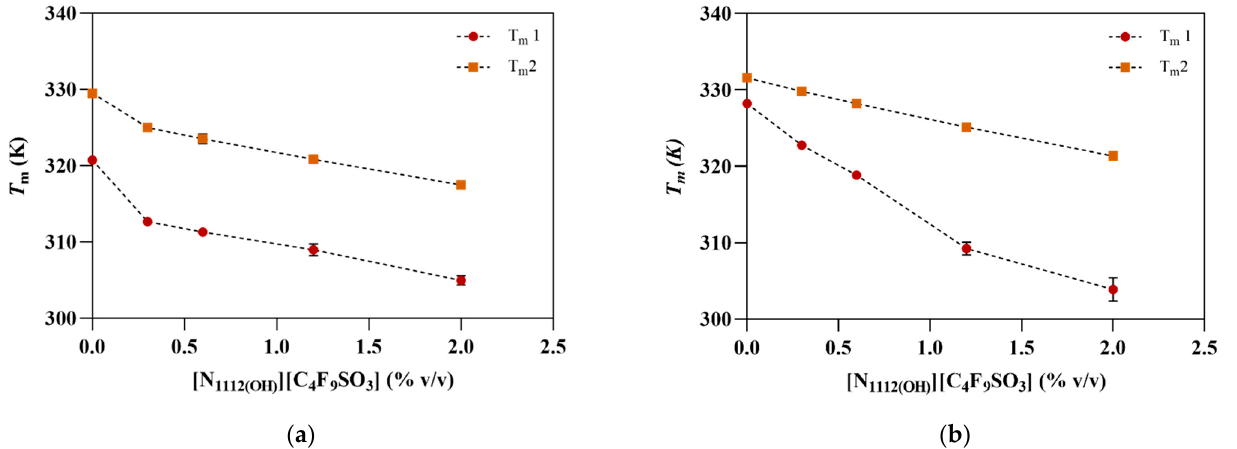
Figure 3. Thermostability of hPAH in the absence and presence of increasing concentrations of [N 1112(OH) ][C 4 F 9 SO 3 ]. T m values obtained from nanoDSF for hPAH ( a ) in the absence and ( b ) presence of 1 mM L-Phe. Data are shown as mean ± SD of triplicate